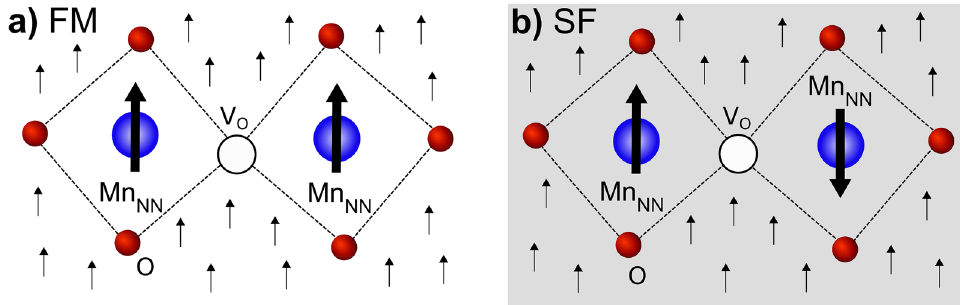
Figure 2. Schematics of the two magnetic configurations in the proximity of the vacancy. ( a ) Ferromagnetic state (FM). ( b ) Spin-flip state (SF). Mn NN (blue spheres) stands for the Mn atoms nearest neighbors to the oxygen vacancy ( V O , white sphere) and O (red spheres) represents oxygen atoms. The ferromagnetic host is represented by the upright arrows in the